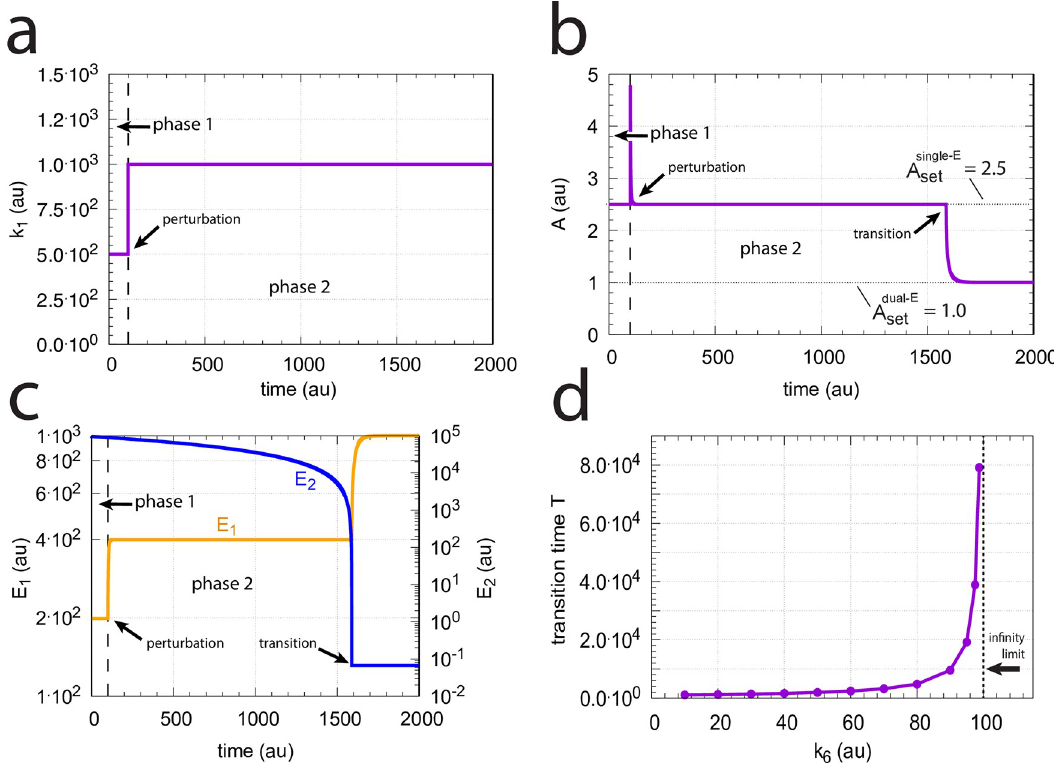
Fig 34. Metastable single-E controller and critical slowing down in the autonomous transition from single-E to dual-E control mode. (a) Step-wise change of k 1 at t = 100.0 from 500.0 (phase 1) to 1000.0 (phase 2). (b) Metastable single-E control mode. The single-E controller defends its set-point (=2.5), but transition to dual-E control mode (indicated by arrow) occurs at approximately 1600 time units when E 2 reaches its steady state. (c) The metastable single-E control mode is operative as long as E 2 is above its steady state value. The transition from single-E to dual-E control mode occurs when E 2 has reached its steady state (indicated by arrow). Rate constants: